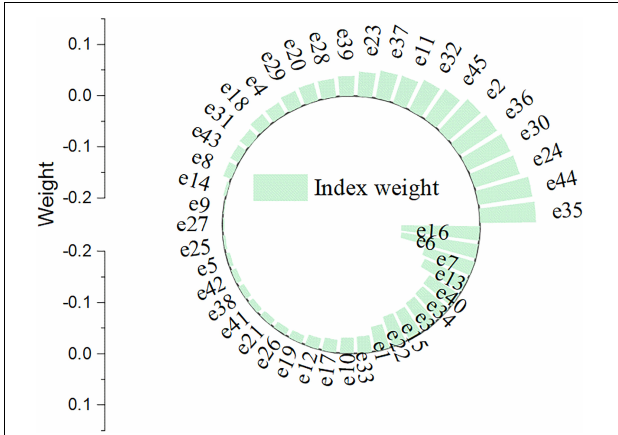
FIGURE 3 | Weights of National Wetland Assessment Indicators in Plateau Cities. For the meaning of EI, please refer to the table notes.